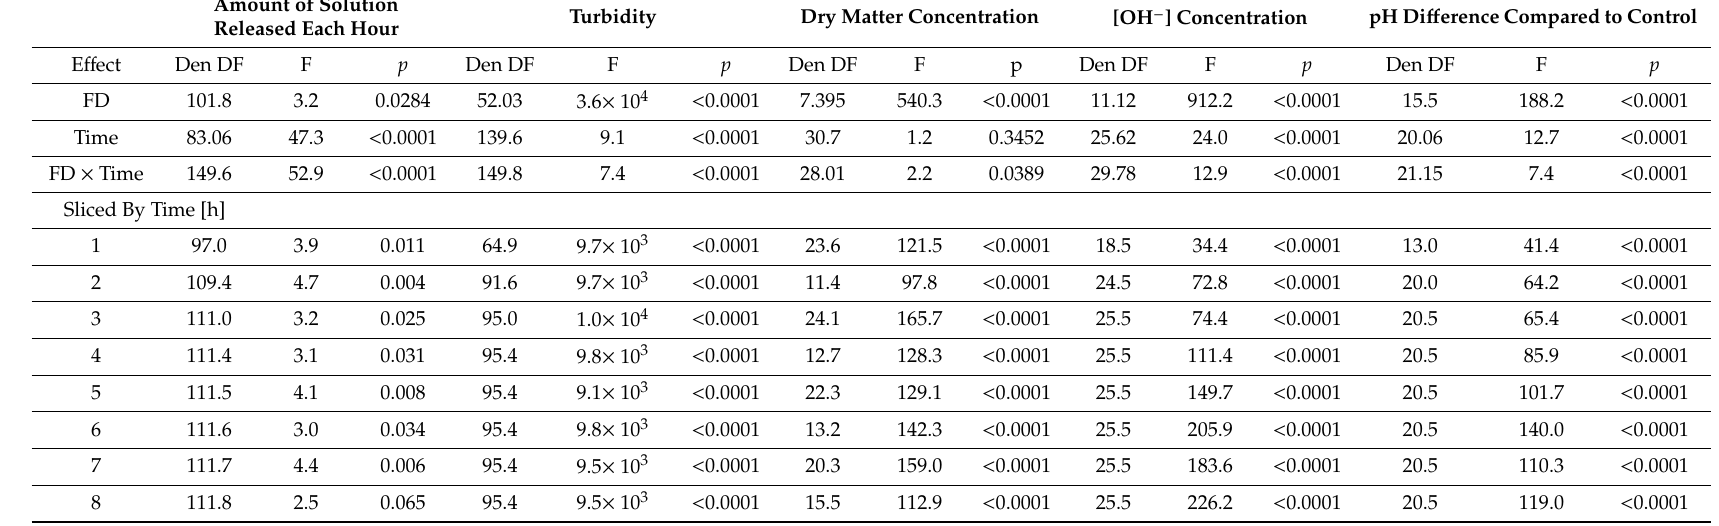
Table 2. Results of the statistical analysis (degrees of freedom estimate of the error (DF den); F statistics; and p values) of the general linear mixed model applied to the amount of solution released each hour, its turbidity, dry matter concentration, pH di ff erence compared to the control, and the amount of OH − released with the solution per hour (expressed as mol ton − 1 ). Factors were the solution dilution (FD) and variation in time (1-h step of a 8-h irrigation cycle). Data were analyzed with a repeated treatment option and after which di ff erences by each time-step were sliced. When the p -values were lower than 0.05, F and p were shown in bold. See the Supplementary Material for the post-hoc